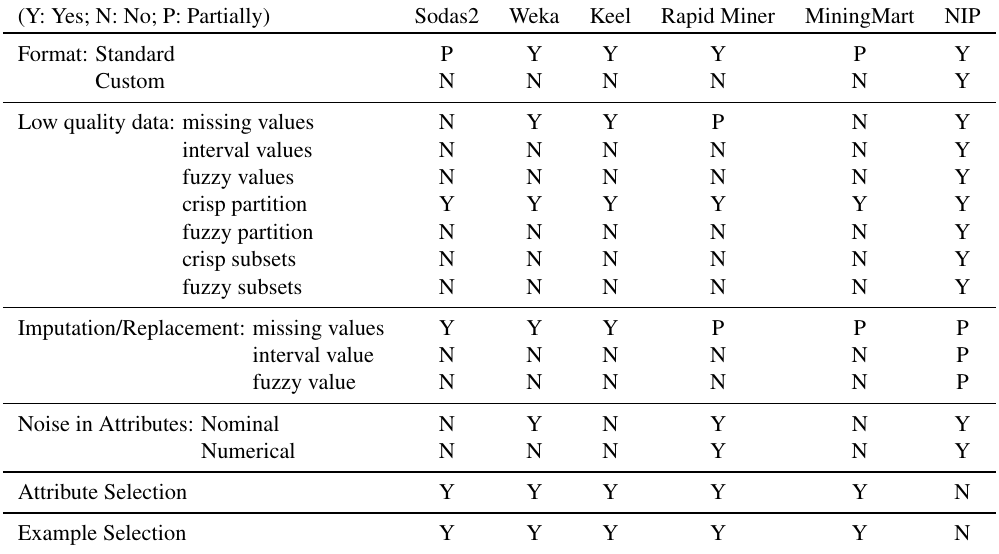
Table 1: Comparative of Characteristics of Software Tools with regard to data